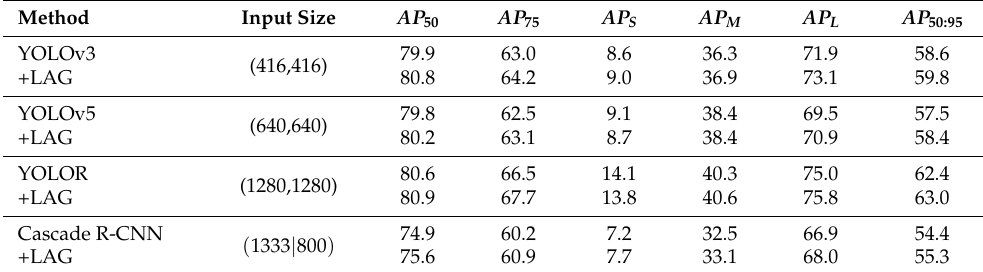
Table 6. The effects of LAG on different detectors under the DIOR dataset.